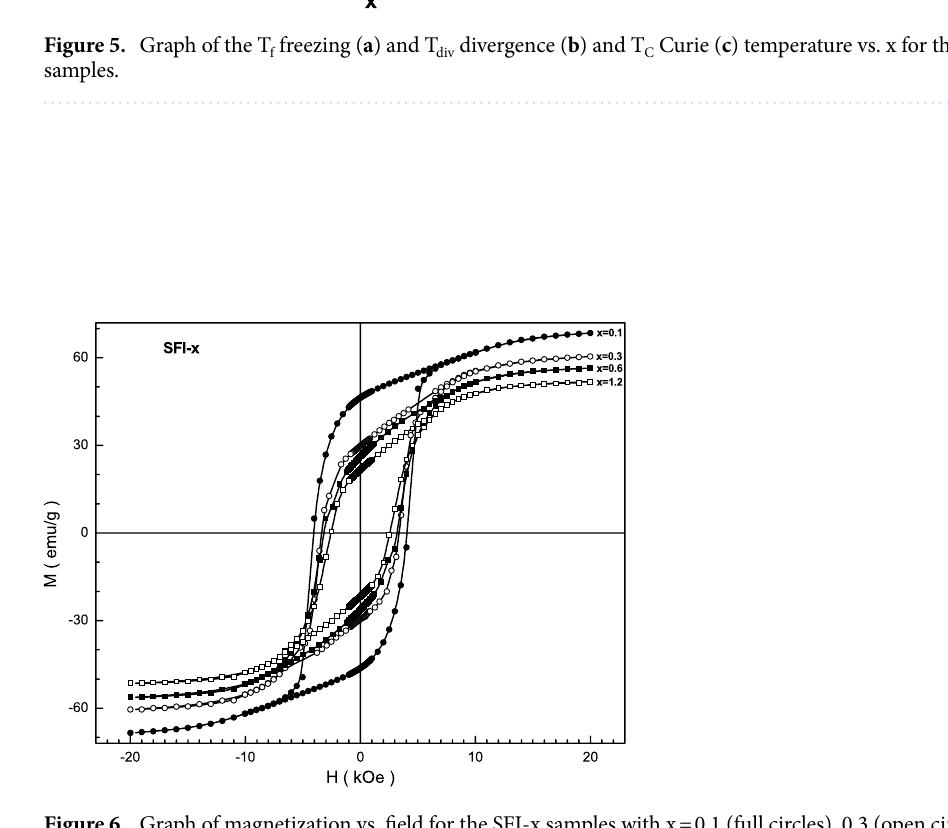
Figure 6. Graph of magnetization vs. field for the SFI-x samples with x = 0.1 (full circles), 0.3 (open circles), 0.6 (full rectangles) and 1.2 (open rectangles) at 300